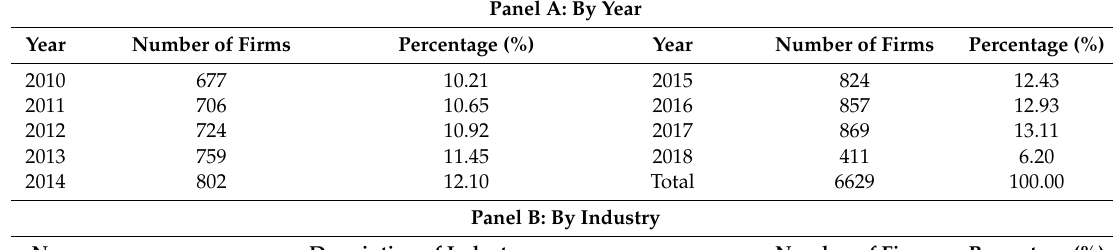
Table 2. Distribution of sample firms. Panel A: By